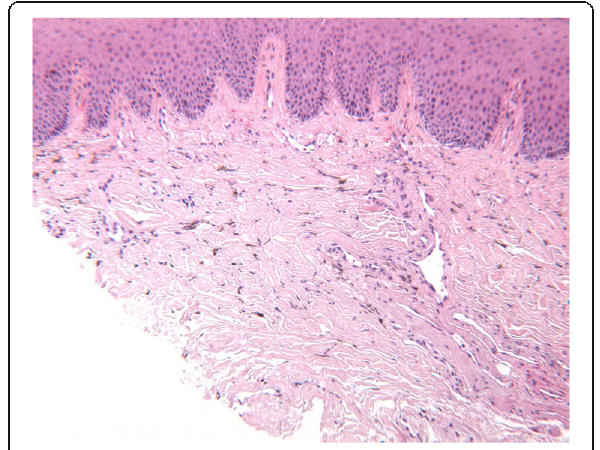
Fig. 4 The lamina propria of the oral mucosa contained brown-staining spherical particles that included melanin (Fontana – Masson staining,